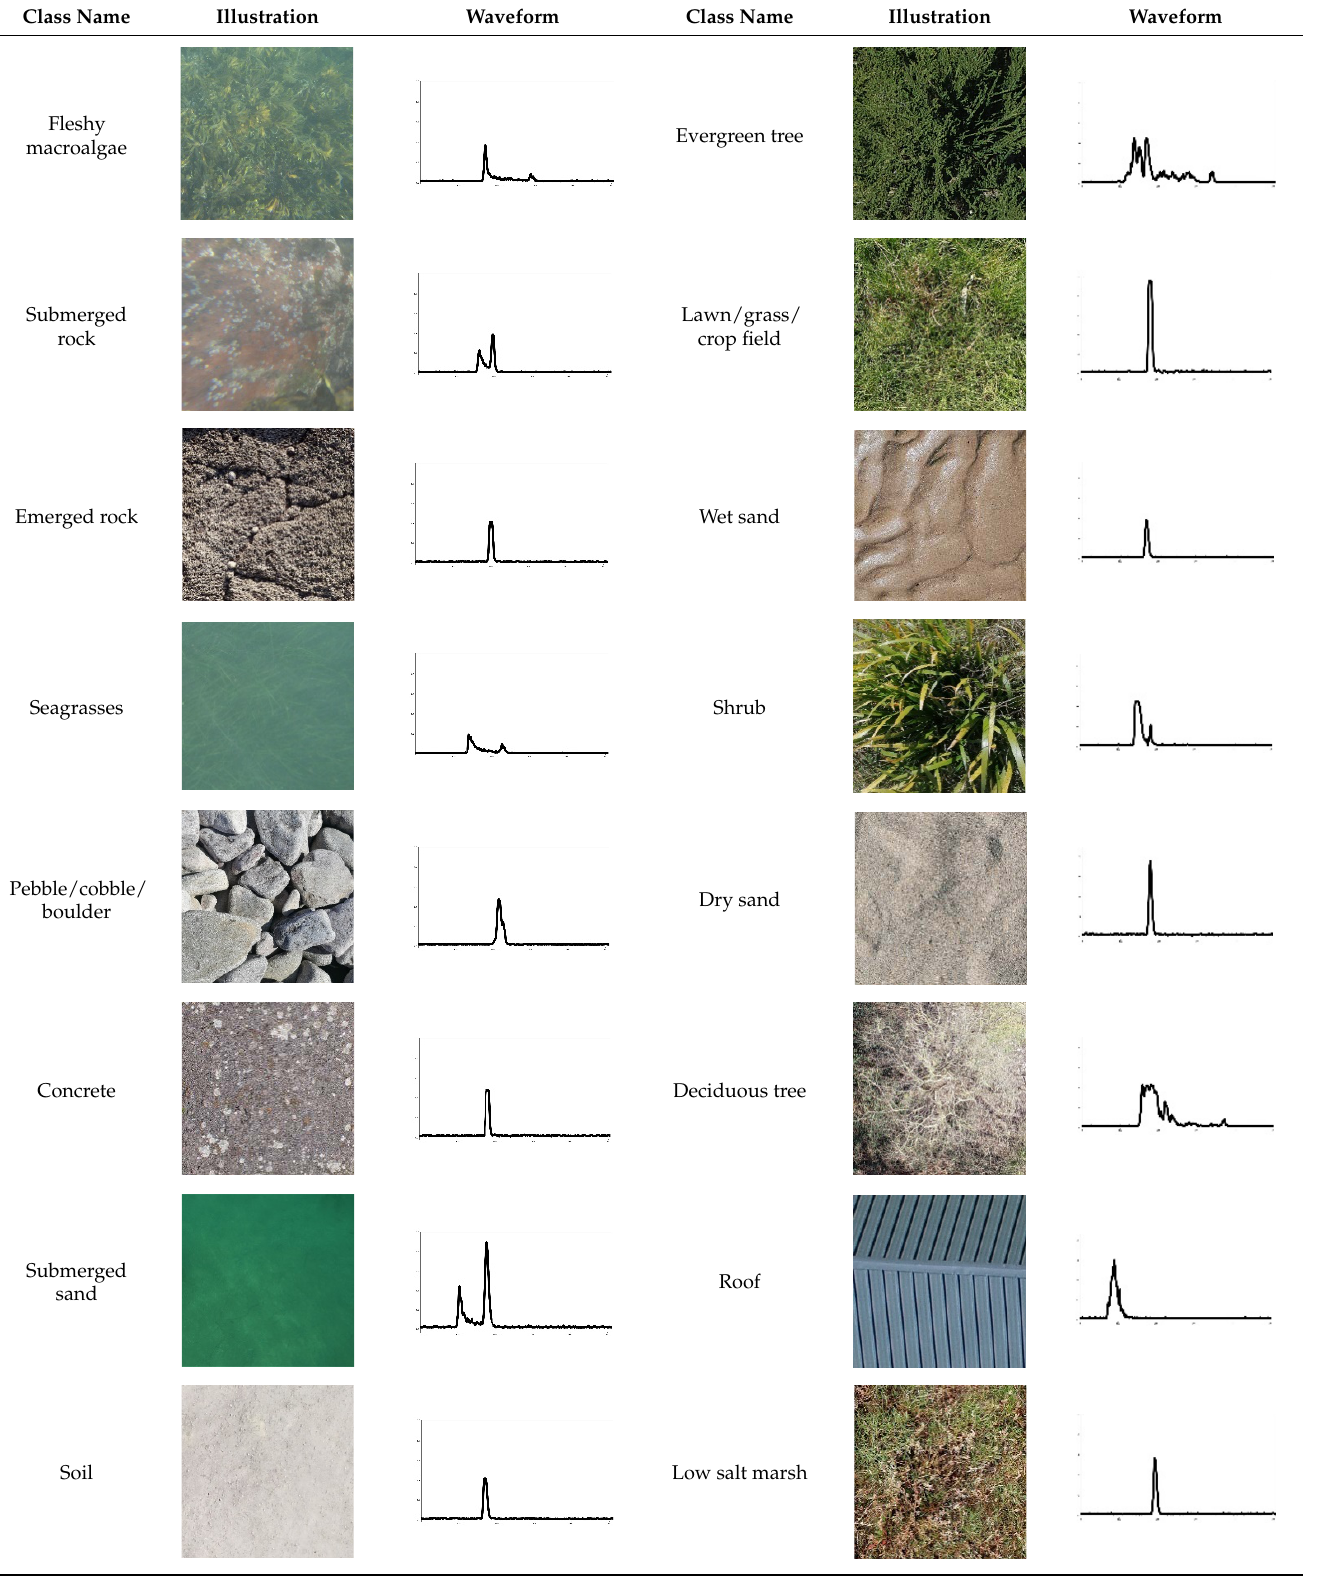
Table 1. Classes of land and sea covers identified in the study area.